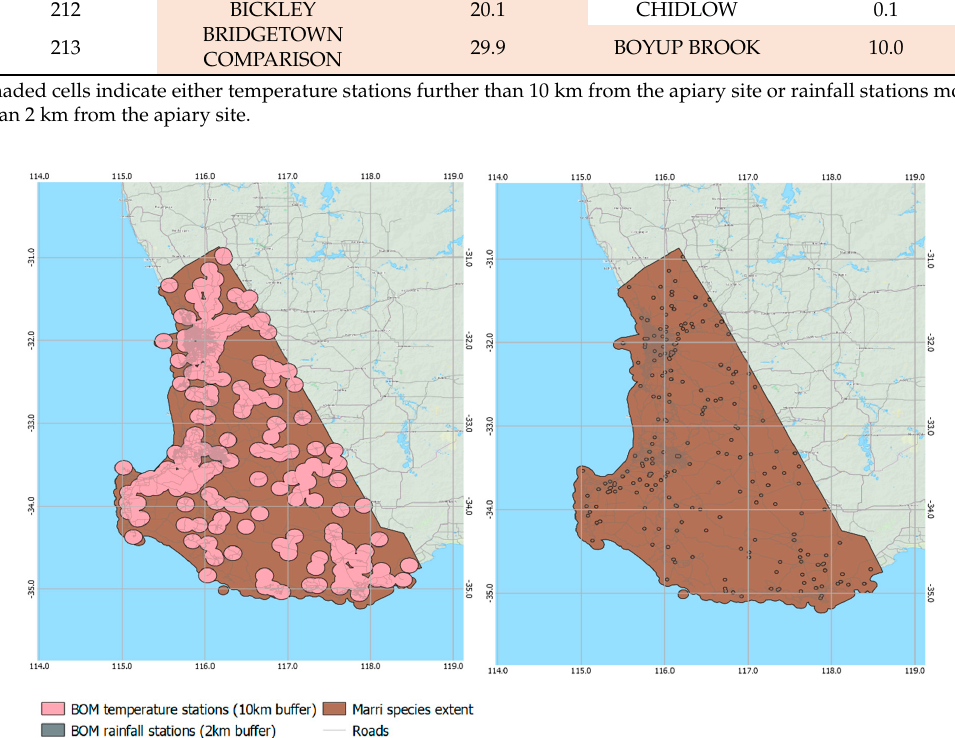
(b) winter cold front Figure 5. Examples of rainfall events from the Perth region viewed in the Bureau of Meteorology (BOM) rain radar for Perth [18] for ( a ) a localised and intense summer storm event in January (highlighted in red), and ( b ) the storm front of a winter thunderstorm in July. 2.3. Satellite-Derived Data All other input datasets for modelling were derived from the Moderate Resolution Imaging Spectrometer (MODIS) sensor which is carried on the Terra and Aqua satellites [19], with data retrieved from the Application for Extracting and Exploring Analysis Ready Samples (AppEEARS) online portal [20]. A summary of the scientific basis for the creation of these datasets follows below.